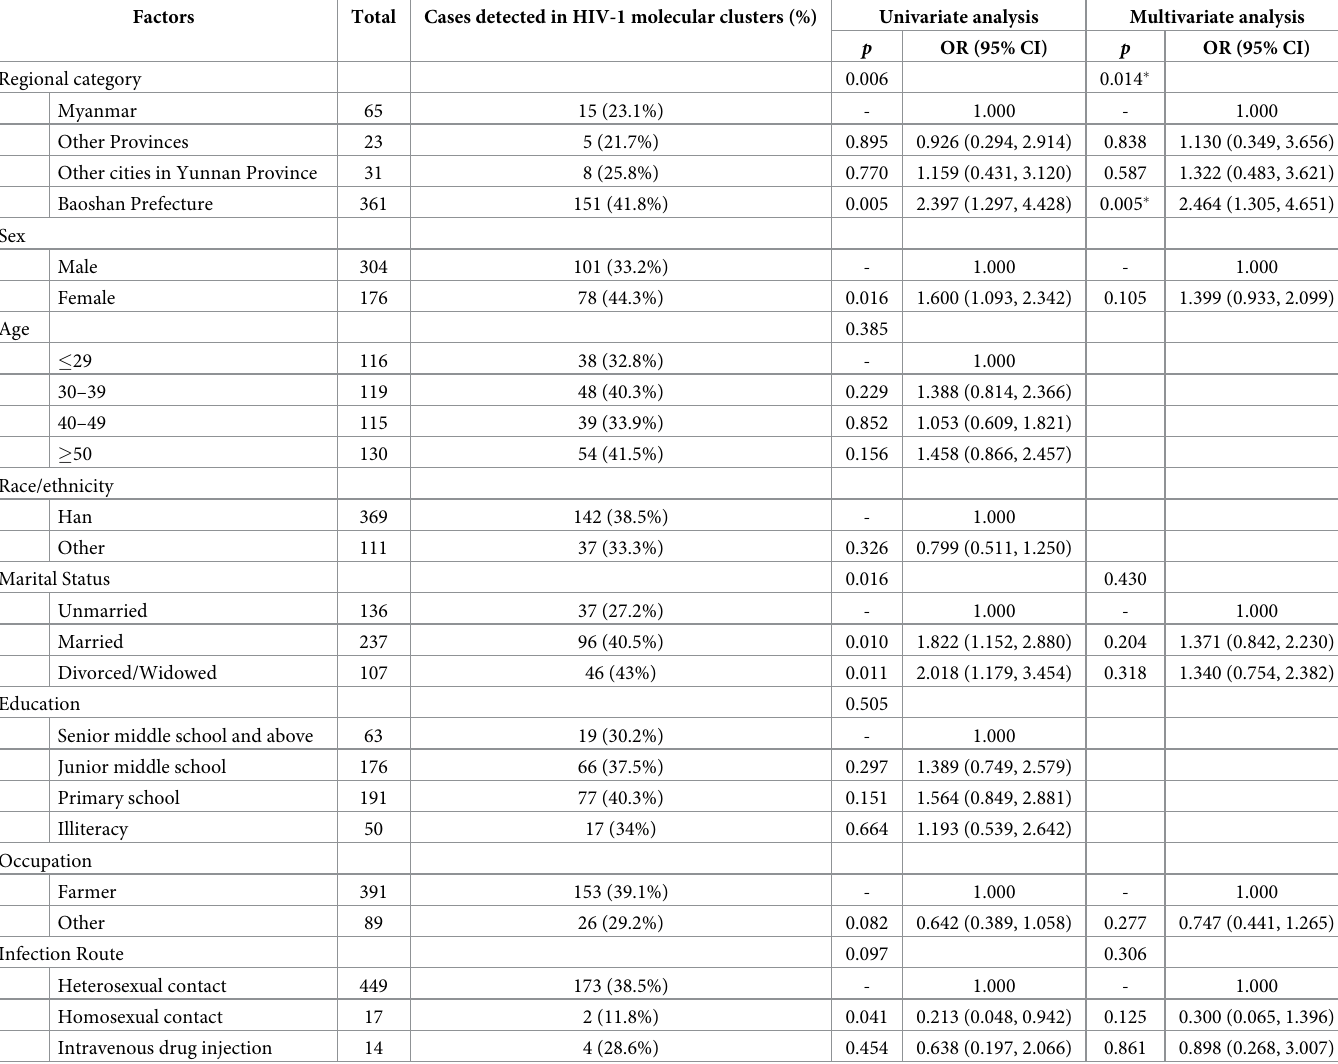
Table 2. Associated demographic factors of the individuals clustering in the HIV-1 molecular